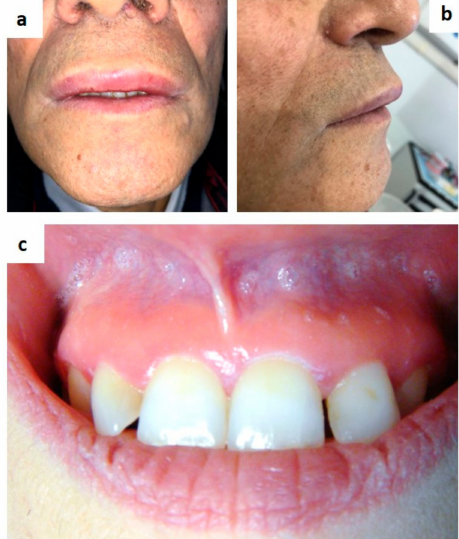
Figure 12. ( a – c ) Classic upper lip swelling in patient with oro-facial granulomatosis ( a ); the gingival onset as diffuse gingivitis (mostly of the maxillary adherent gingiva and unrelated to plaque or calculus) is reported to be very rare in unaware